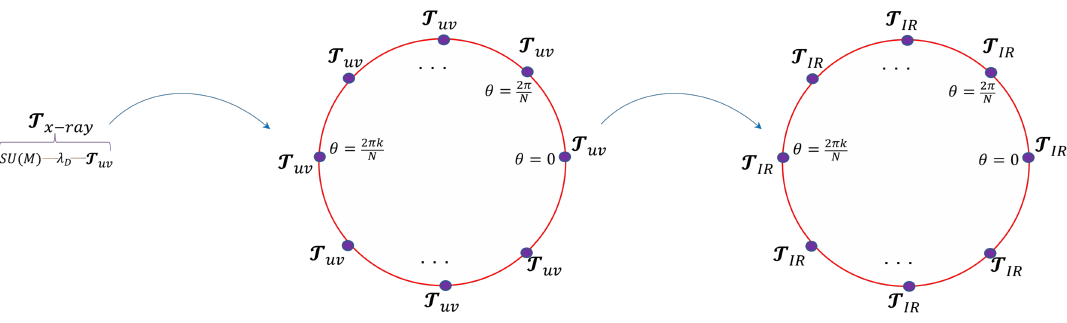
Figure 1 . This figure represents the flow of the theory. We start at high energies with T x − ray which is a modification of T by an extra gauge group SU( M ) and a fermion λ . Confinement of uv D SU( M ) leads to a spontaneous breaking of the axial Z symmetry. In each vacuum we have T N uv with a different θ angle. In the presence of massless fermions, the θ angle can be rotated away, with the price of generating different background θ terms for global symmetries in each vacuum. At low energies, T flows to T . The demand that N copies of T will be consistent with the anomalies uv IR IR of T put constraints on the flow of T x − ray uv